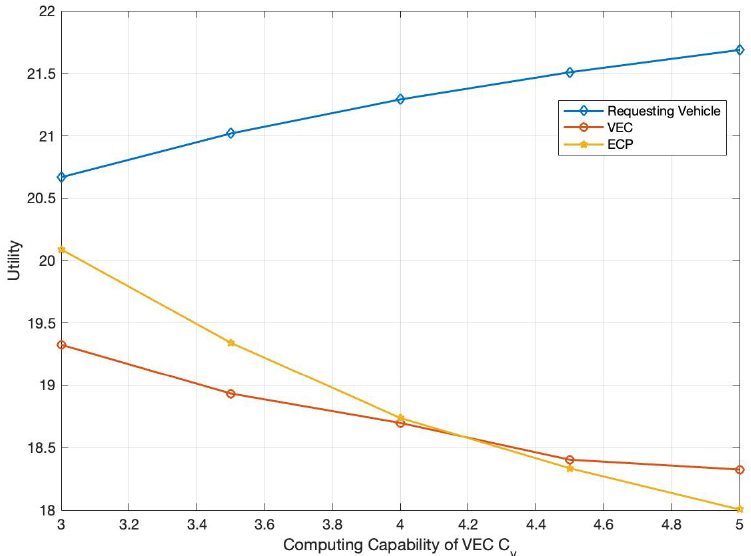
Figure 8. The Utilities of the edge server, ECP, and requesting